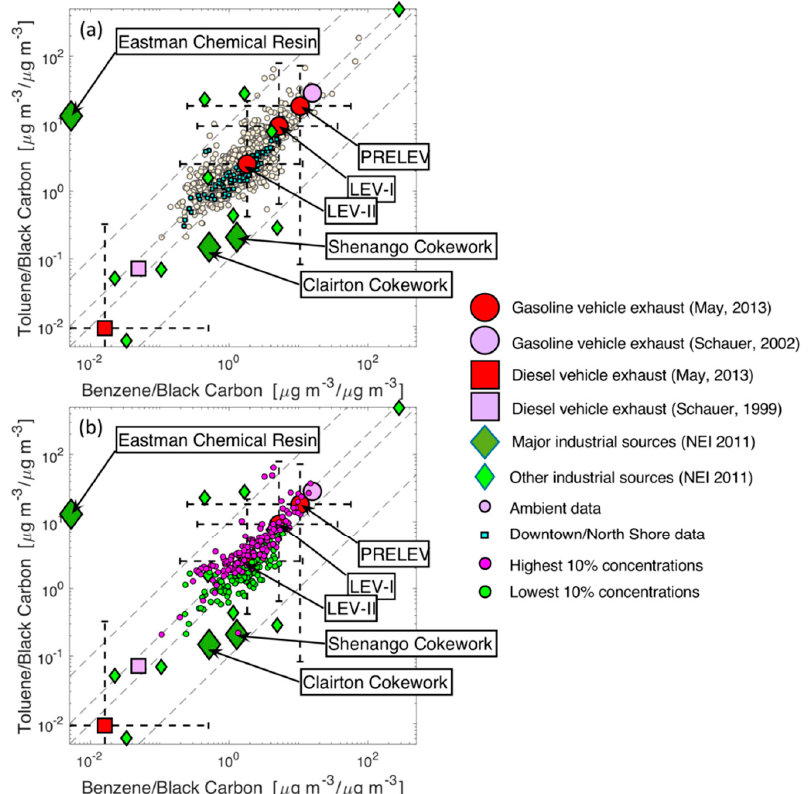
Figure 7. Ratio-ratio plot with benzene and toluene concentrations normalized by Black Carbon (BC). ( a ) All samples (white dots) and samples from Downtown/North Shore (cyan squares) are plotted on a log scale. ( b ) Top 10% highest total VOC concentrations are plotted as magenta circles and lowest 10% total VOC concentrations are plotted as green circles. Gasoline vehicle (large circles) and diesel vehicle (large squares) emission profiles, as well as industrial emission profiles in Pittsburgh (diamonds) are overlaid to visualize the source impacts.